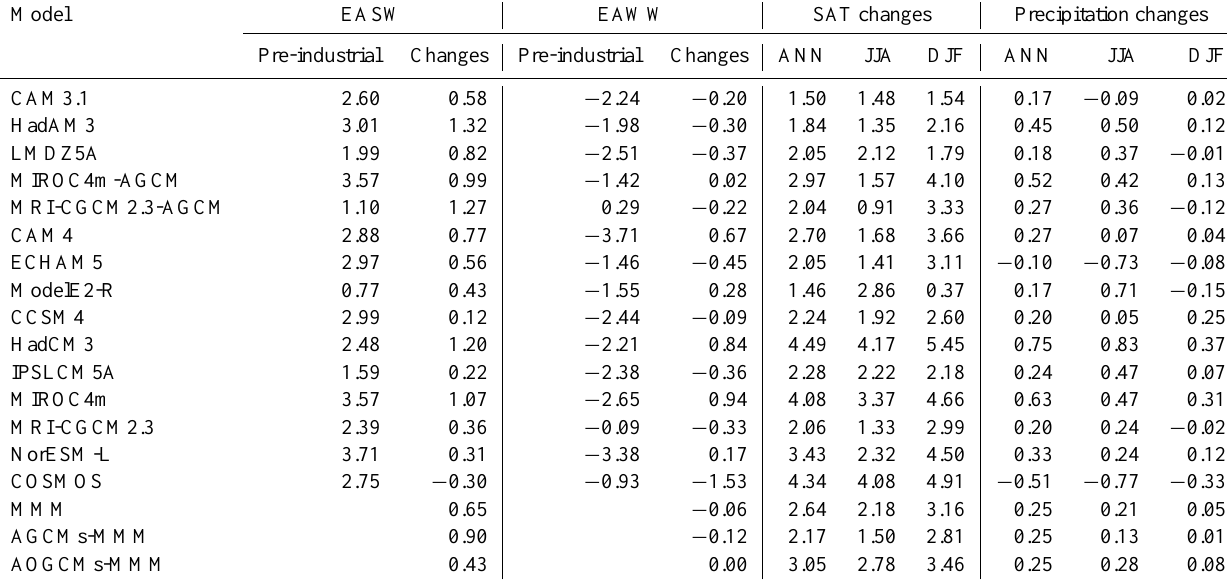
Table 3. The regionally averaged changes of EAWW, EASW, SAT and precipitation between mid-Pliocene and pre-industrial experiments. The EAWW and EASW indices (units: ms − 1 ) are calculated by regionally averaged meridional wind speed at 850hPa within the region of 20–45 ◦ N and 105–135 ◦ E. The SAT (units: ◦ C) and precipitation (units: mmday − 1 ) changes are calculated by regionally averaged values within